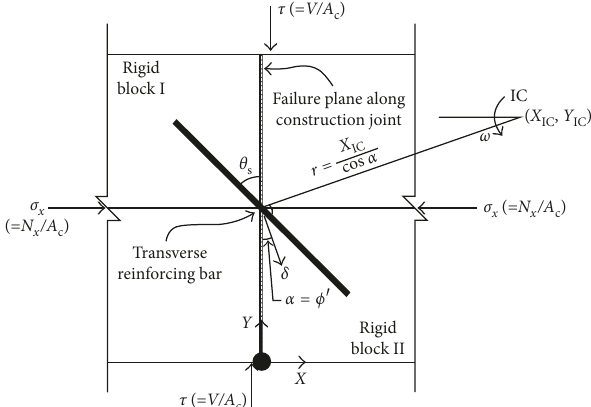
Figure 2: Idealized failure mechanism of the concrete interface with construction